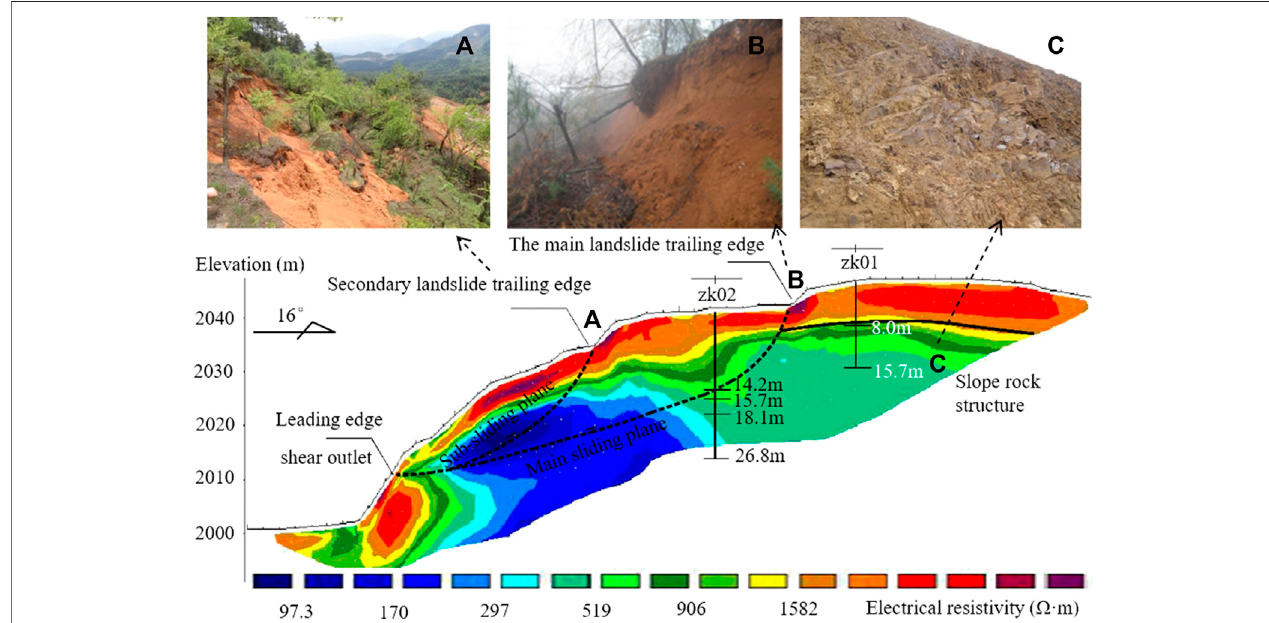
FIGURE2| InterpretationresultsoftheWernersectionanddeformationcharacteristics. (A) :Secondarylandslidetrailingedge, (B) :Themainlandslidetrailingedge, (C) : Slope rock structure.